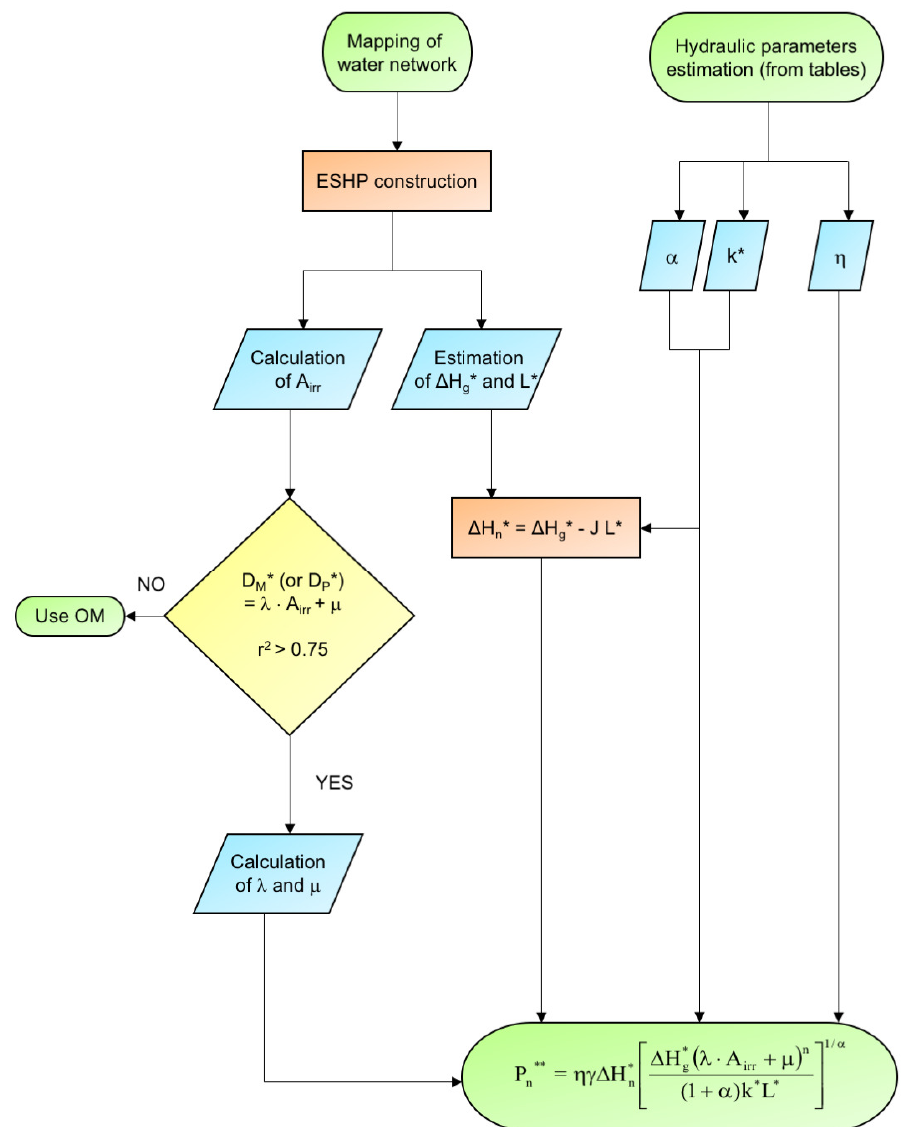
Figure 1. Flow chart of the simplified method for evaluating SHP energy production in collective irrigation systems.